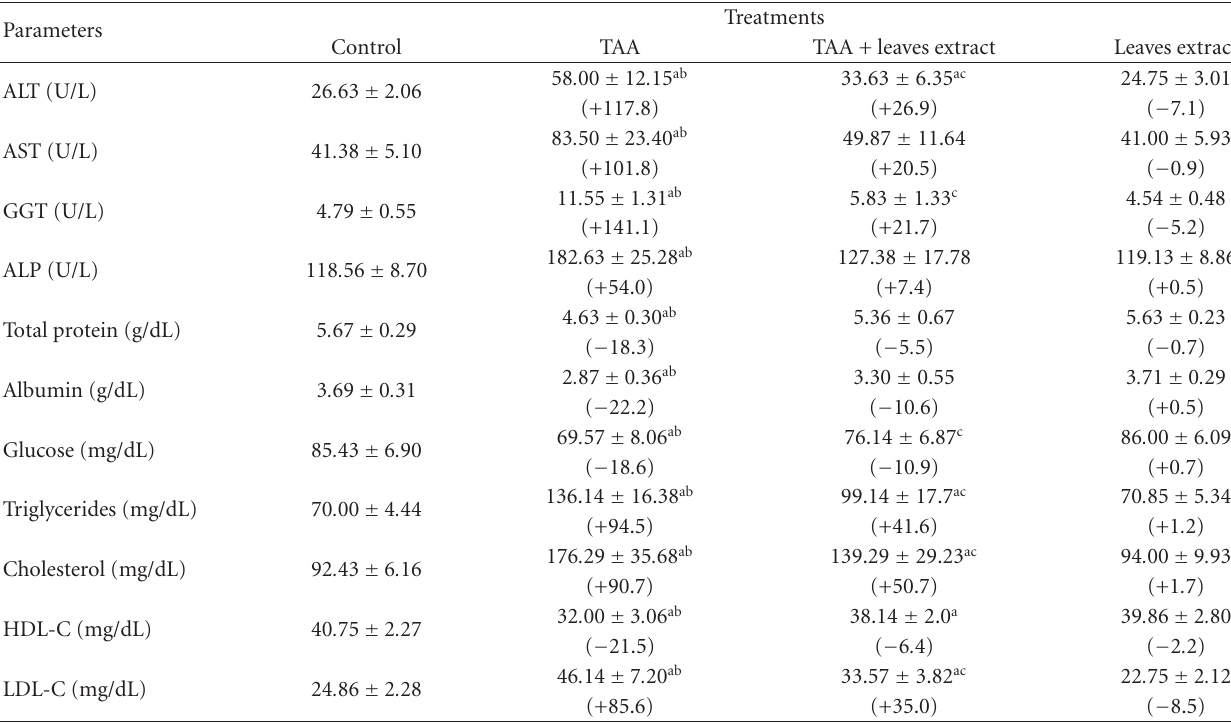
Table 1: Plasma ALT, AST, GGT, ALP, total protein, albumin, glucose, triglycerides, cholesterol, HDL-L, and LDL-C levels (mean ± SD) of control, TAA, TTA plus G . biloba leaves extract, and G . biloba leaves extract treated mice ( n = 7). Percentage changes are included in